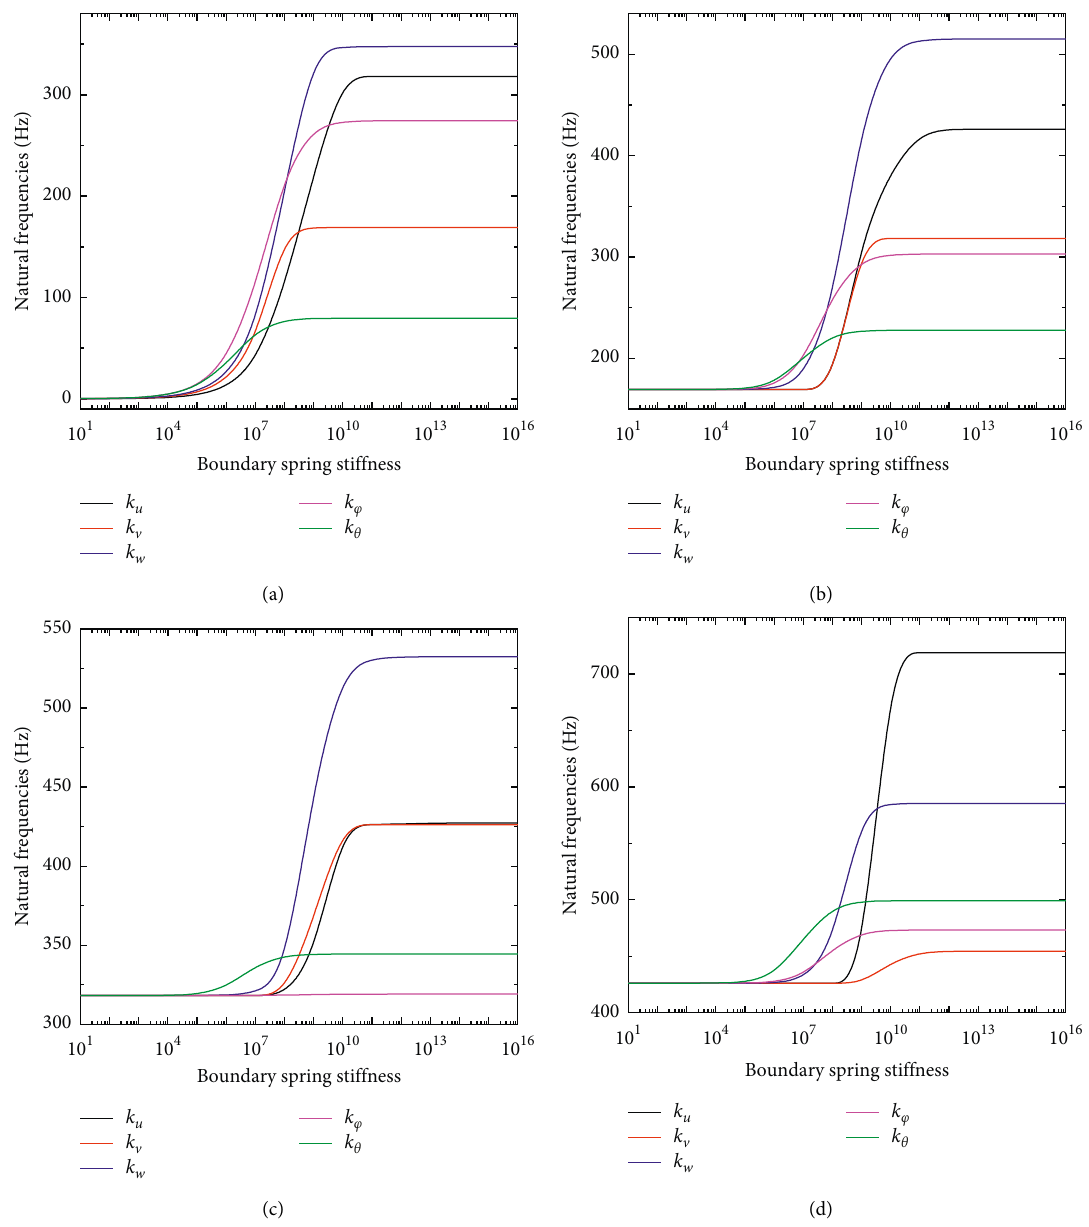
Figure 5: Convergence characteristics of dimensionless frequencies on the boundary spring stiffness. (a) Mode1. (b) Mode2. (c) Mode3. (d) Figure 6 represents the comparison results between steady-state responses in the non-stepped and multi-stepped FG-CNTRC plate under the CCCC boundary condition. The geometric and material parameters are the same as those shown in Tables 5 and 6. The ranges of natural frequency are from 300 to 900 in the non-stepped plates and from 300 to 800 in the multi-stepped plates, respectively. The interval is set as 1 Hz. Here, the harmonic point force f w acts in the thickness direction.